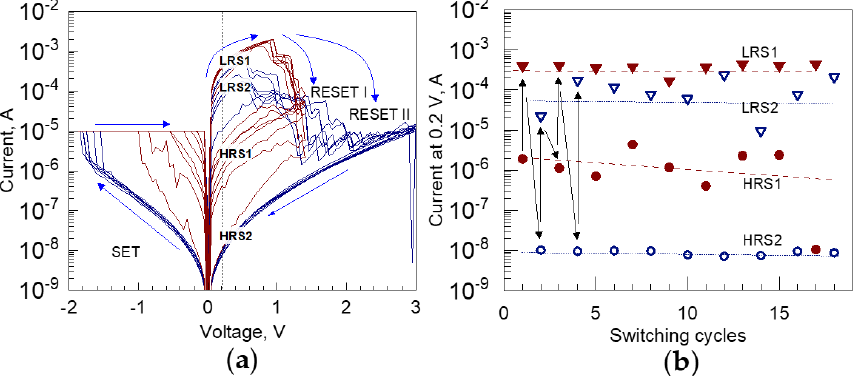
Figure 10. ( a ) Current–voltage characteristics and ( b ) endurance characteristic of resistive switching sequences measured in Au/Ti/ZrO 2 :Al 2 O 3 /TiN structure containing 14.3 nm thick ZrO 2 :Al 2 O 3 film grown using the deposition cycle sequence of 30 × (1 × Al 2 O 3 + 4 × ZrO 2 ). Numbered LRS and HRS assign low and high resistivity levels, respectively, recorded at 0.2 V during two-level switching cycles before RESET events depicted in panel ( a ). Arrows in panel ( b ) are guides to eye, following the order of recording currents at different resistivity levels.